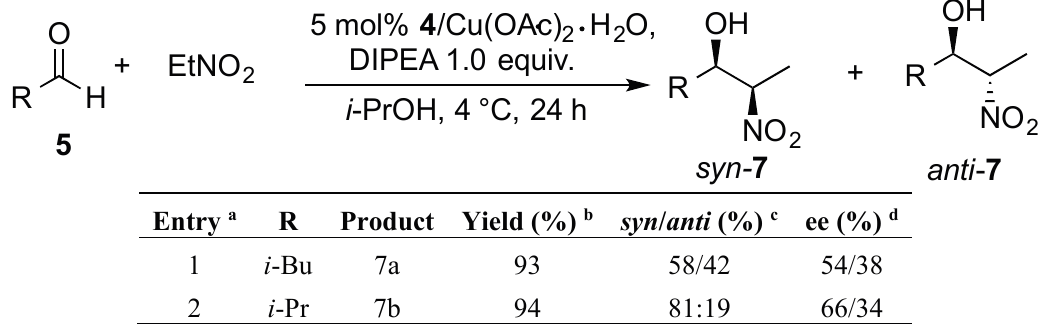
Table 3. Diastereoselective Henry reaction using